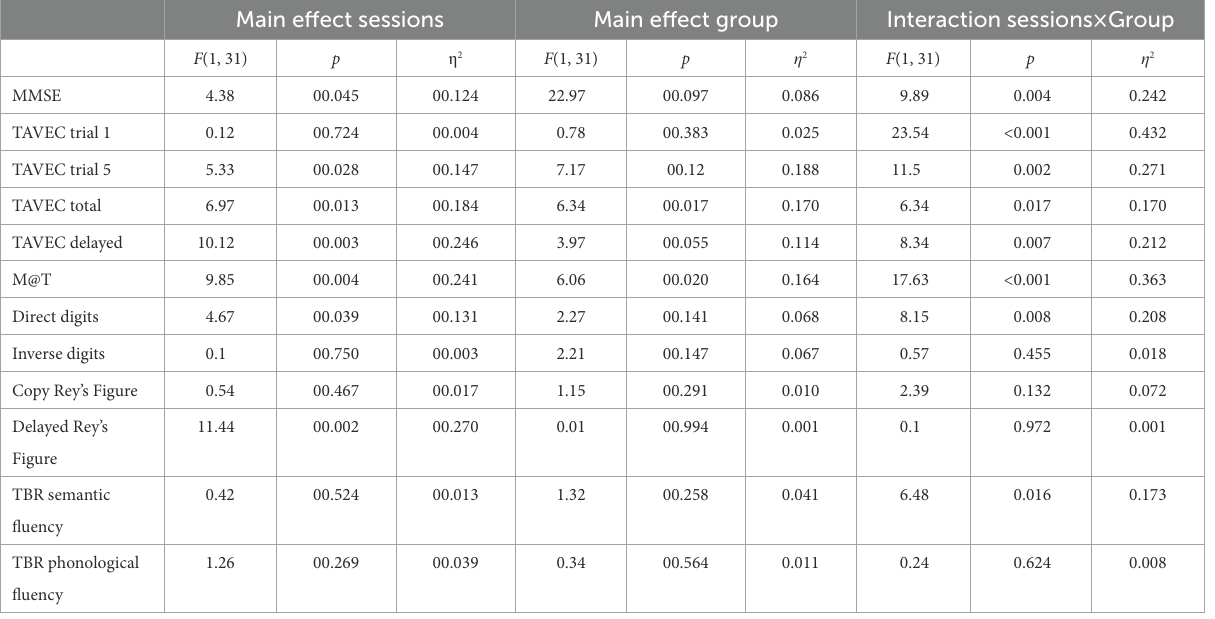
TABLE 2 Main and interaction effects of the mixed ANOVAs with two groups (active vs. sham; between-subjects) × 2 sessions (before vs. after intervention;